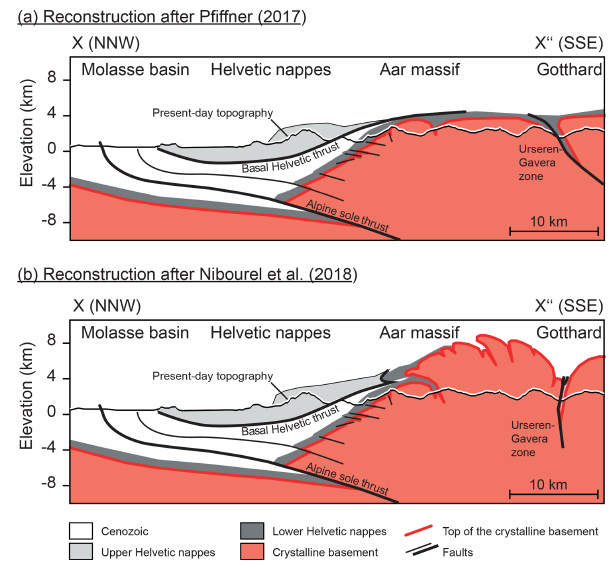
Figure 7. Cross sections from X to X (cid:48)(cid:48) in Fig. 1 through the Aar massif simplified after Pfiffner (2017) and Nibourel et al. (2018). (a) The reconstructed top of the crystalline basement in the Aar massif is located ca. 1–2km higher than the present-day topography according to Pfiffner (2017). (b) In a revised version by Nibourel et al. (2018) the contact between the basement and the overlying Helvetic cover nappes is reconstructed to be steeper, resulting in ca. 8km of (now eroded) crystalline crust on top of the present-day